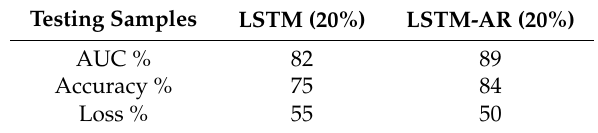
Table 5. LSTM / LSTM-AR models and DSS reading automatism: AUC, accuracy and loss results. Testing